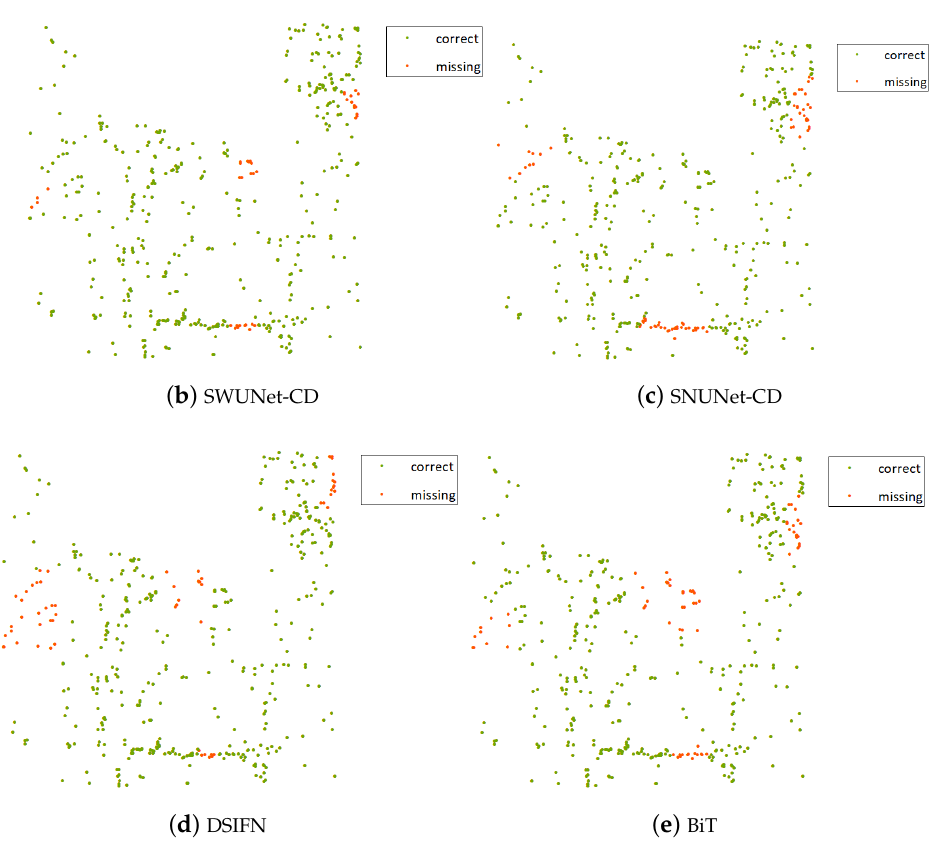
Figure 8. ( a ) The extent of the test area. ( b ) Intersection spots by SWUNet-CD. ( c ) Intersection spots by SNUNet-CD. ( d ) Intersection spots by DSIFN. ( e ) Intersection spots by